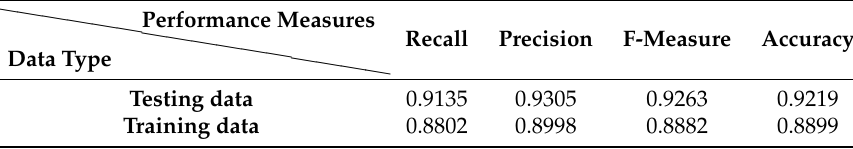
Table 6. Performance measures when only using IE as